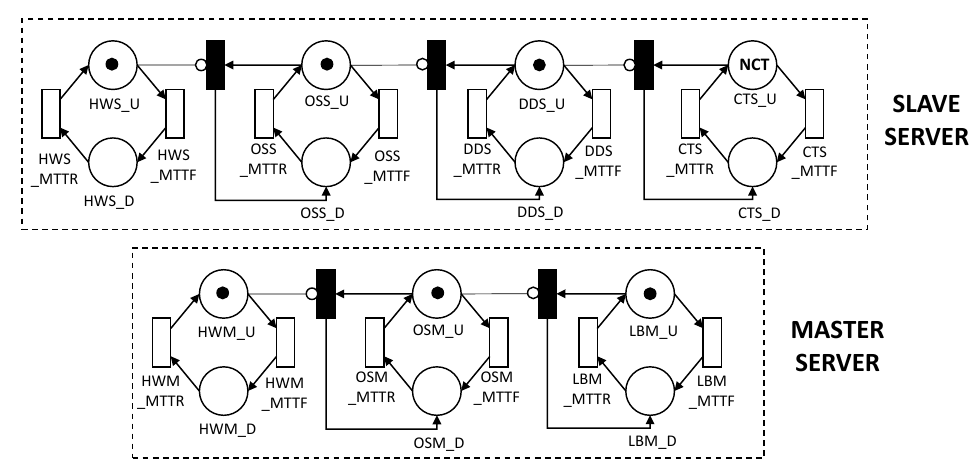
Figure 13. SPN base model for an MEC architecture with master–slave layout.